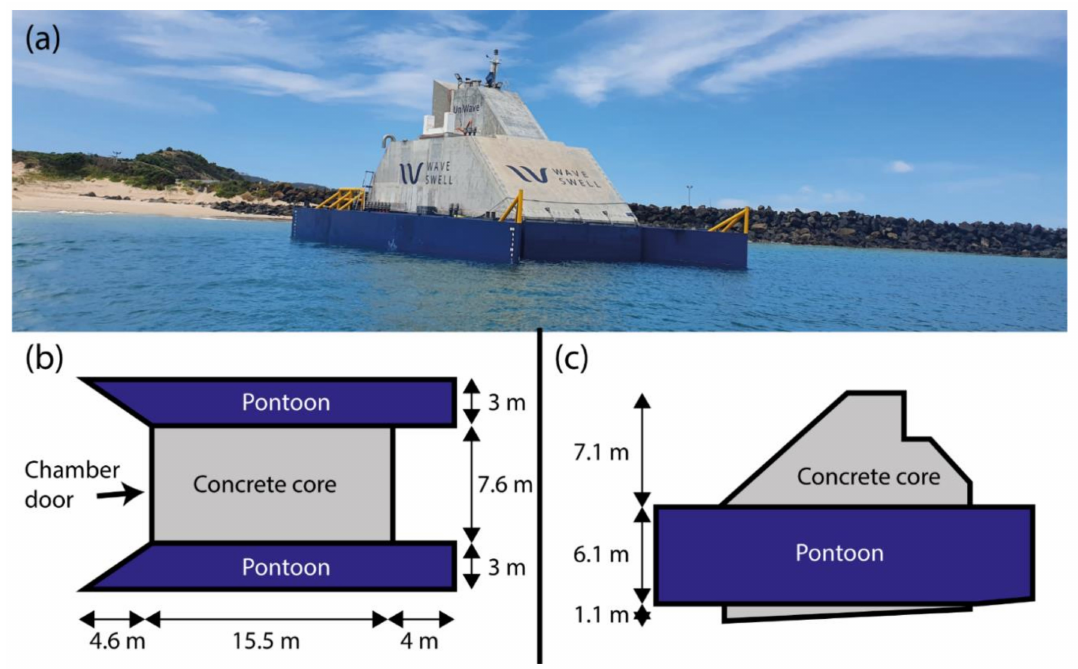
Figure 1. ( a ) Overview of Grassy, King Island, Tasmania, Australia. ( b ) Location 1 and Location 2 of the OWC WEC with a bathymetric overlay (0.5 m contours) measured on 3 December 2020, stated levels are m LAT.